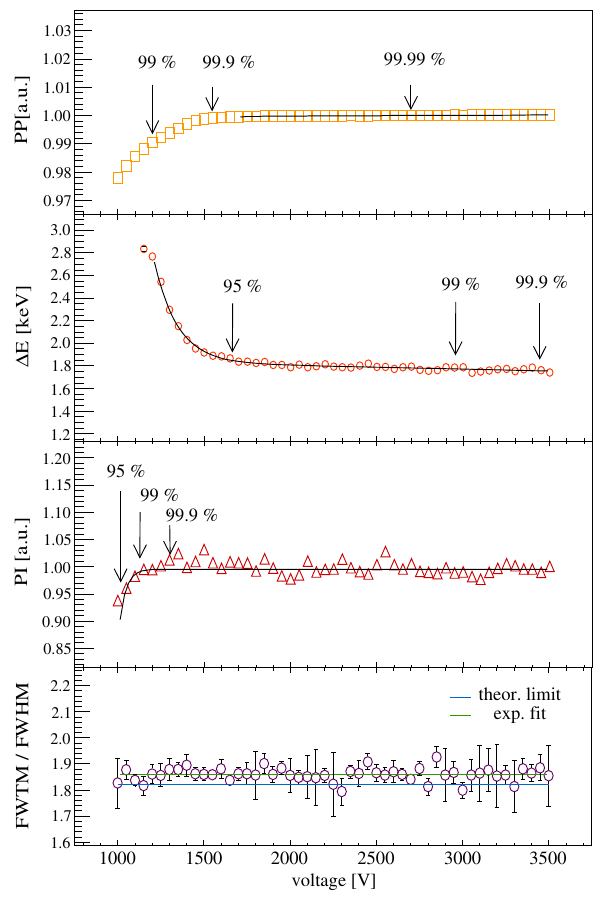
Fig. 3 Characteristic HV scan curves of detector GD00B based on the evaluation of the 1333 keV γ line from a 60 Co calibration source. The three curves of the peak position, energy resolution and peak integral areusedforthedefinitionofthefulldepletionandoperationalvoltagein Gerda . Additionally, the peak asymmetry curve in the bottom canvas demonstrates that the Gaussian peak form is conserved over a large voltage interval. More explanations are included in the